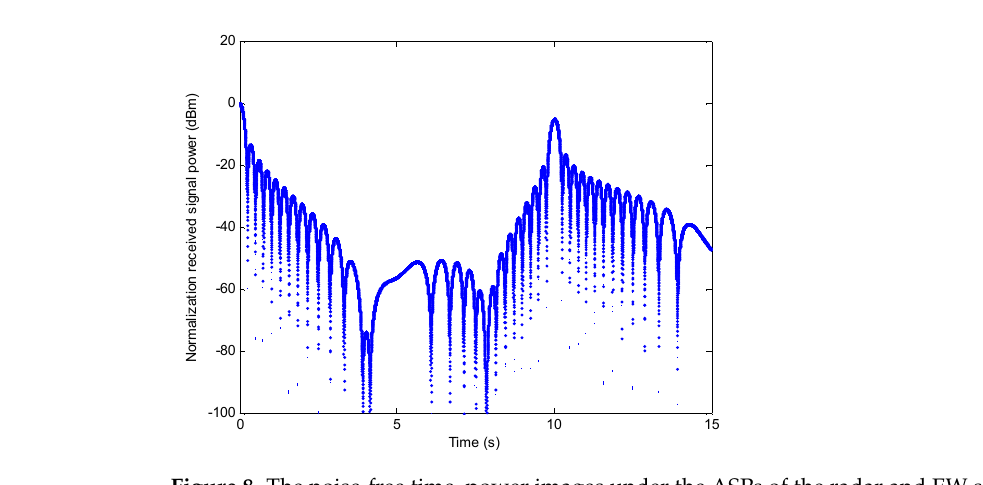
Figure 8. The noise − free time − power images under the ASPs of the radar and EW system of 10 s and 12 s, respectively.